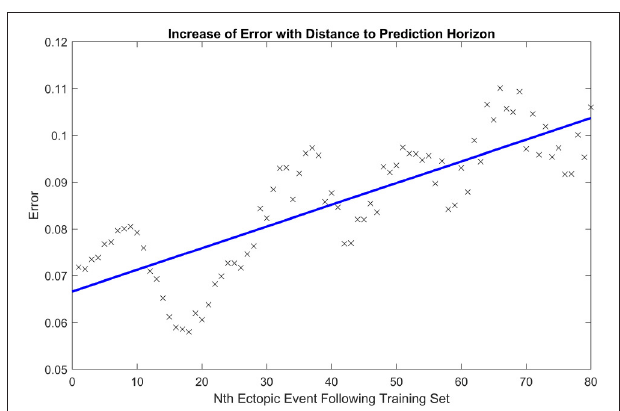
FIGURE 5 | Increase of error with prediction horizon. Illustrating how the root mean squared error in the activation time curve scales as the number of the ectopic event N increases away from the initial ten ectopic events used to calibrate model parameters. The line of best fit is displayed in blue. The periodicity in the error is likely due to rhythmic movements of the patient, such as